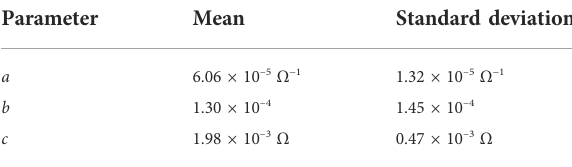
TABLE 1 Means and standard deviations of error model parameters fi tted to the Site 2 reciprocal error distributions at each time-step. Parameter